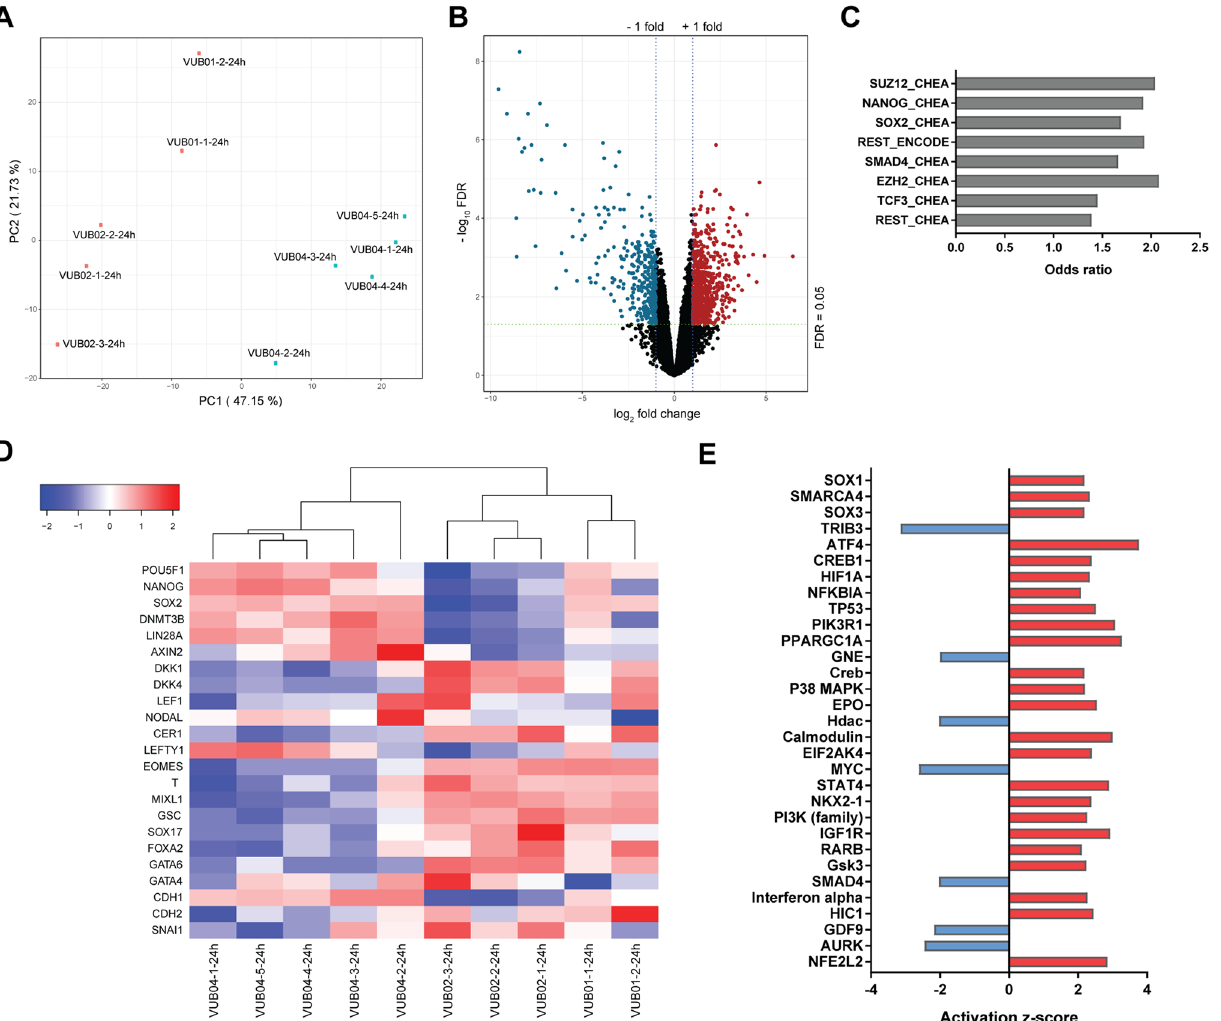
Figure 4. Transcriptomic profile after 24-h DE differentiation suggests inefficient activation of WNT signalling in VUB04. ( A ) Principal Component Analysis of dimension 1 versus dimension 2 based on normalized transcriptome data. ( B ) Volcano plot based on comparison of gene expression levels between VUB04 and the control group (VUB01 and VUB02). Genes with |log2 fold change|> 1 and FDR < 0.05 were marked as either significantly upregulated (red) or downregulated (blue). ( C ) Transcription factor enrichment for the top deregulated genes (|log 2 fold change| and FDR < 0.05) in VUB04 done by Enrichr tool. ( D ) Heatmap for gene expression levels (normalized counts per million) of pluripotency genes, WNT and NODAL signalling downstream targets, DE and epithelial-to-mesenchymal transition markers in the control group and in VUB04 after 24-h DE differentiation. ( E ) Prediction for upstream regulators of differentially expressed genes in the 24-h DE VUB04 samples with |log 2 fold change|> 1 and FDR < 0.05 done by Ingenuity Pathway Analysis. Only the upstream regulators with the activation z-score higher than 2 or lower than -2 and p-value < 0.05 are VUB02 as a control group, as they robustly differentiate towards mesendodermal derivatives (Figs. 1, 2), indicat- ing efficient activation of WNT signalling. As in the undifferentiated state, VUB04 displayed a different expres- sion profile, clustering away from the control lines (Fig. 4A). There were 1054 genes expressed twofold higher or lower in VUB04 samples than in the control lines at the FDR < 0.05 significance level (Fig. 4B). Transcription factor enrichment analysis indicated that the list of top deregulated genes in VUB04 is significantly enriched for NANOG and SOX2 (Fig. 4C), again suggesting an inefficient exit from pluripotency after 24-h differentiation (Fig. 4D) . While pluripotency genes remained upregulated, many downstream targets of the WNT pathway (e.g. LEF1 , DKK1 , DKK4 ) had little to no expression, and most of the genes associated with primitive streak forma- tion (e.g. MIXL1 , EOMES , T , GSC ) were expressed at a much lower level than in the control group (Fig. 4D). In agreement, Ingenuity Pathway Analysis for upstream regulators predicted that the PI3K/AKT signalling, which is linked to maintenance of the pluripotent state, and GSK3, a negative regulator of the WNT pathway, are acti- vated in the VUB04 samples in comparison to the control group (Fig. 4E).